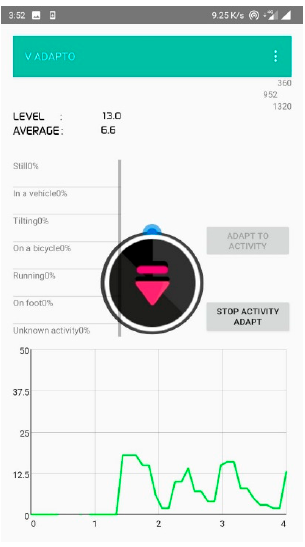
Figure 13. Average Level below 10.